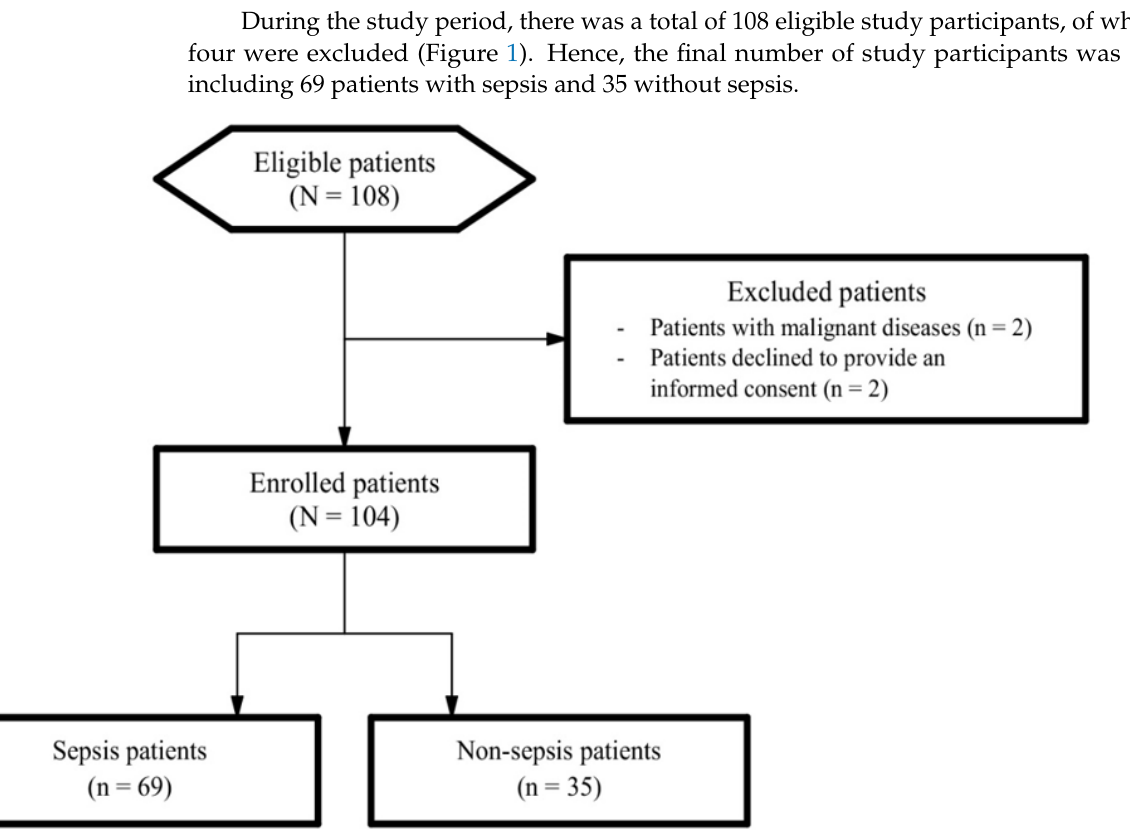
Table 1. General characteristics of 104 study participants.